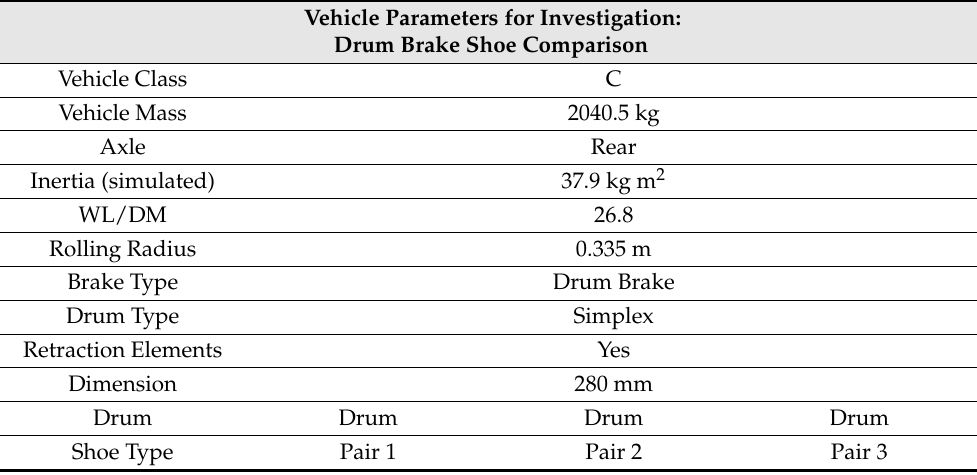
Table 2. Vehicle parameters for investigation: drum brake shoe comparison. Vehicle Parameters for Investigation: